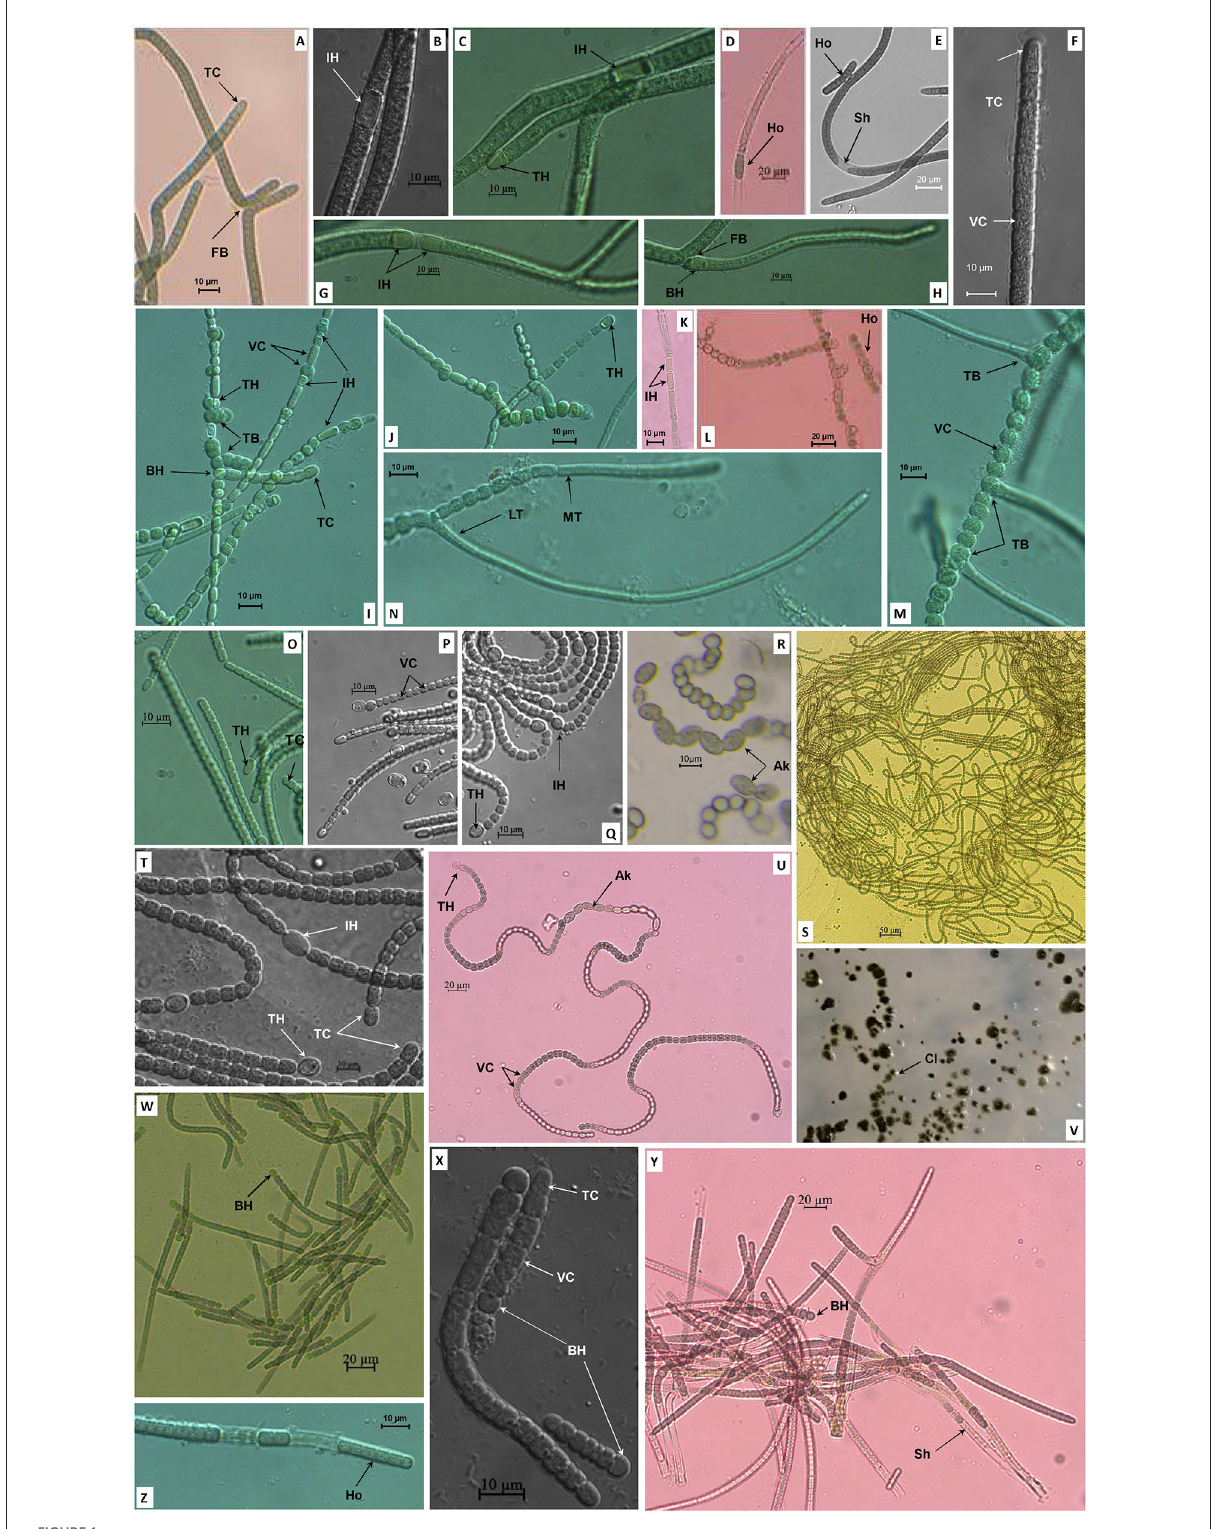
FIGURE1 Morphology of strains NK13 (A–H) , MD2411 (I–N) , NS2000 (O–Q) , NK1813 (R–V) , and XN1103 (W–Z) . TB, True branching; FB, False branching; MT, Main trichome; LT, Lateral trichome; TH, Terminal heterocyst; IH, Intercalary heterocyst; BH, Basal heterocyst; Ak, Akinete; VC, Vegetative cell; TC, Terminal cell; Ho, Hormogonia; Sh, Sheath; Cl,